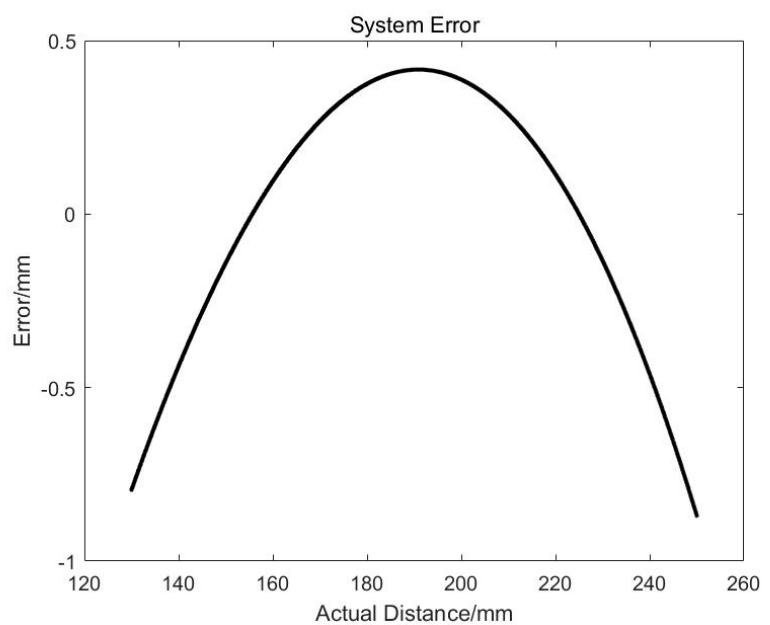
Sensors 2019 , 19 , x FOR PEER REVIEW Figure 11. Theoretical errors of the measurement system. Figure 11. Theoretical errors of the measurement system.